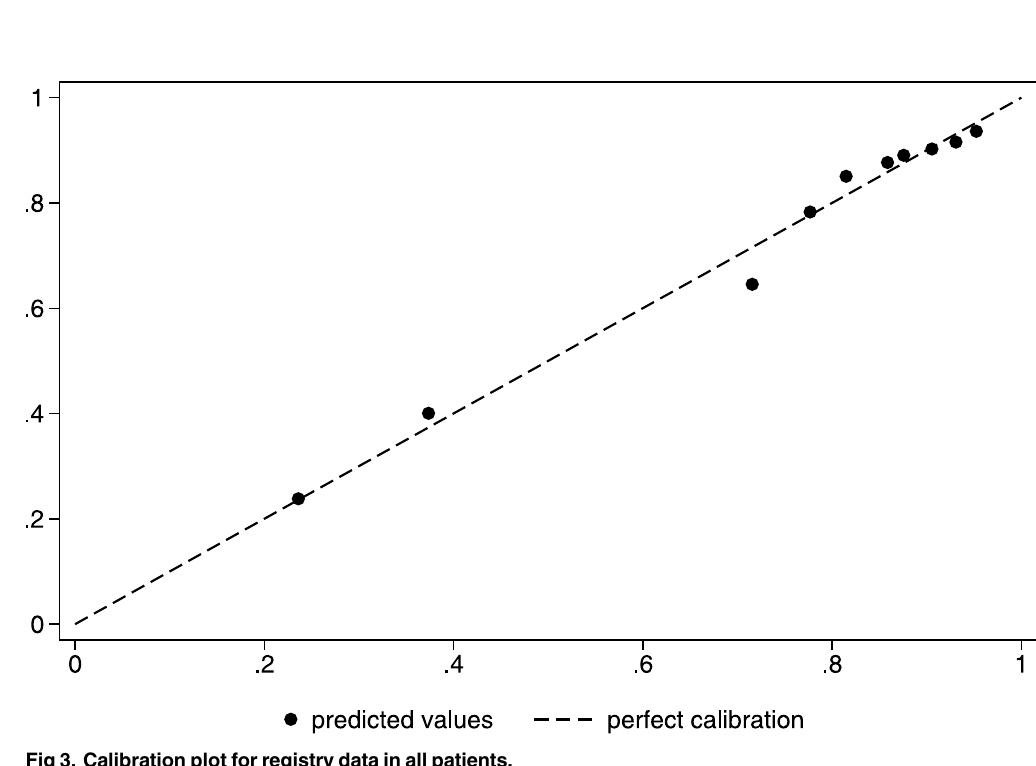
Fig 3. Calibration plot for registry data in all patients.